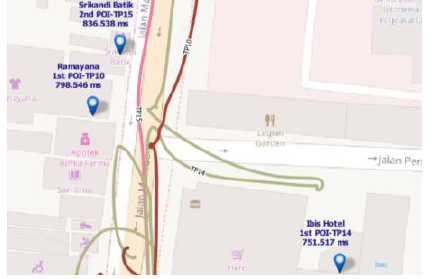
Figure 6. Extracted TPs tracks of TP10, TP14, TP15